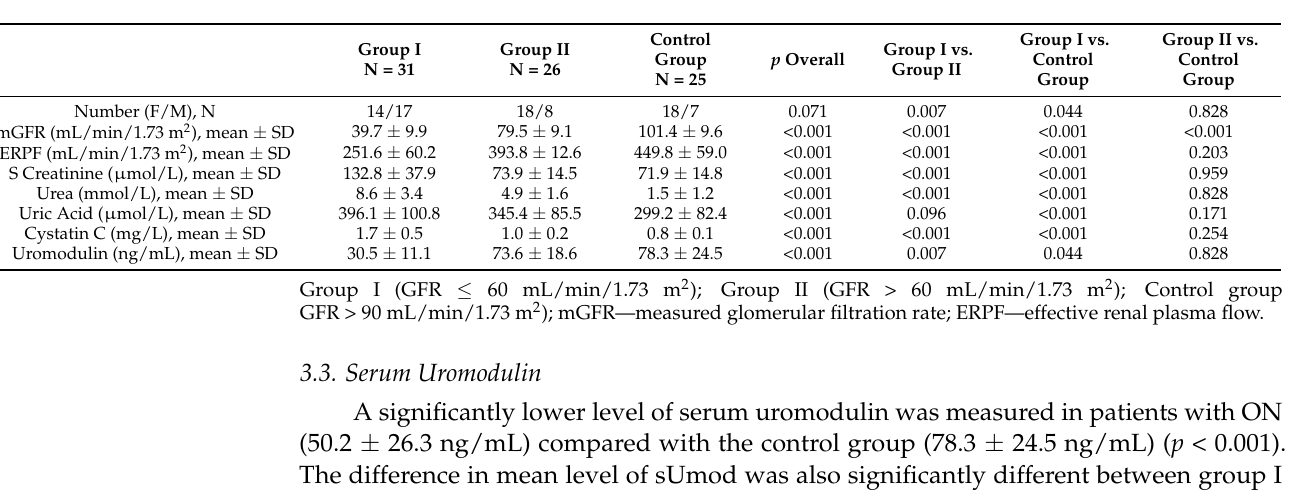
Table 2. Renal function parameters of study population.